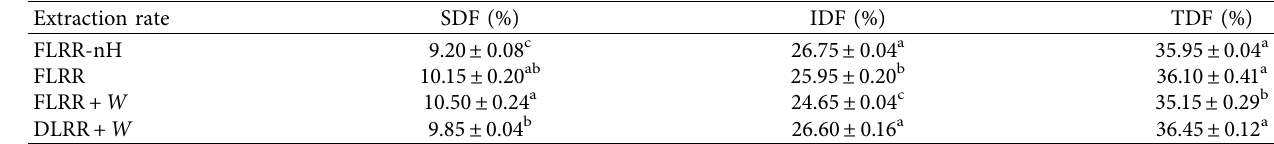
Table 1: Extraction rates of DF fraction from LRRs.